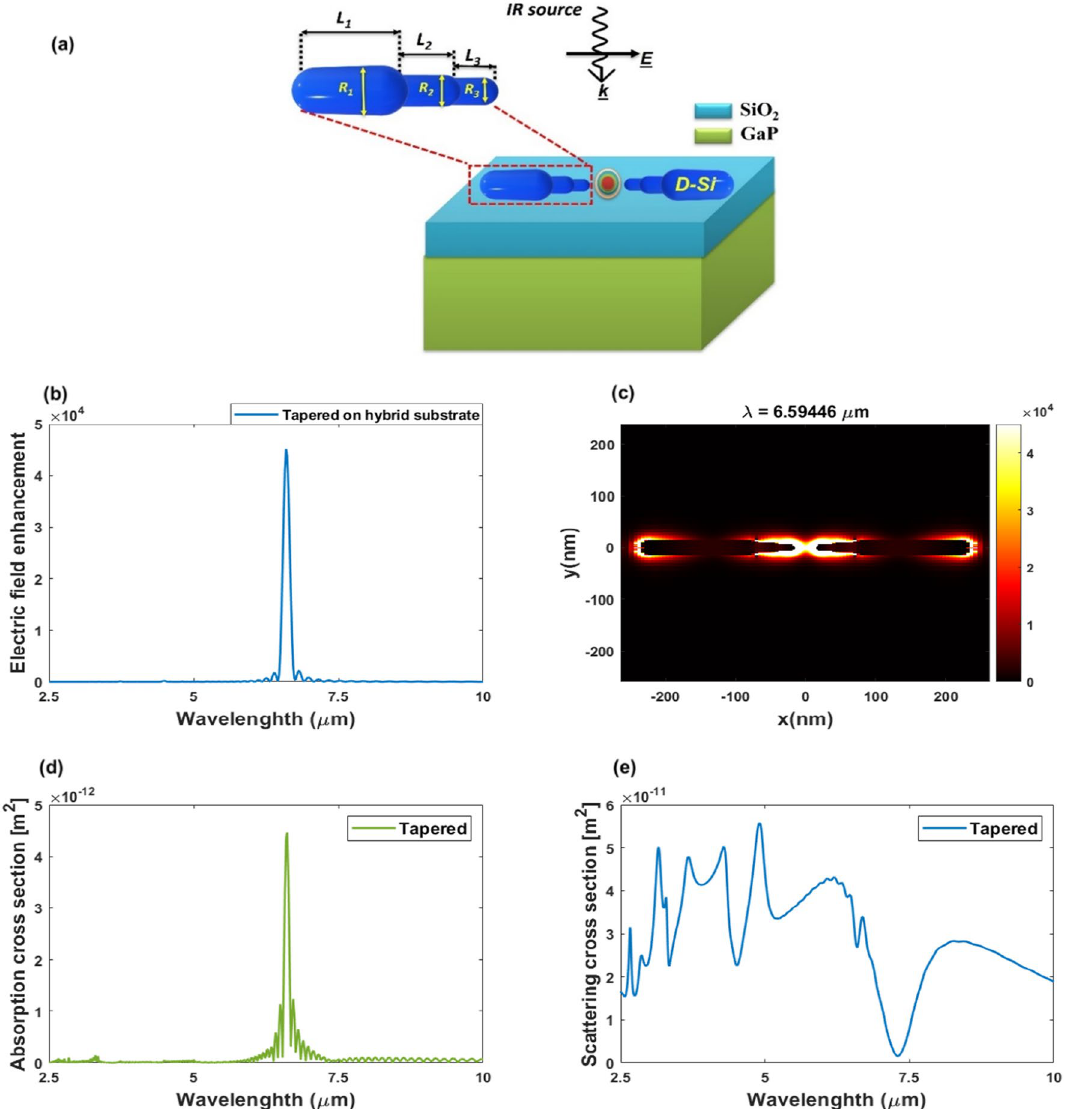
Figure 9. ( a ) The proposed tapered nanorod antenna on hybrid substrate, ( b ) electric field enhancement inside the gap center as a function of the wavelength, and ( c ) the field profile of the tapered nanoantenna at the resonance wavelength. ( d ) The scattering cross section of the tapered nanorod antenna on hybrid substrate as a function of the wavelength. ( e ) The absorption cross section of the tapered nanorod antenna on hybrid substrate as a function of the